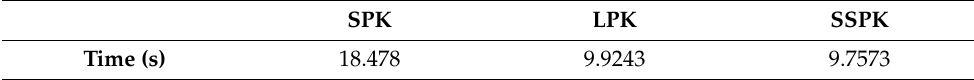
Table 6. Computational time for the third case study.